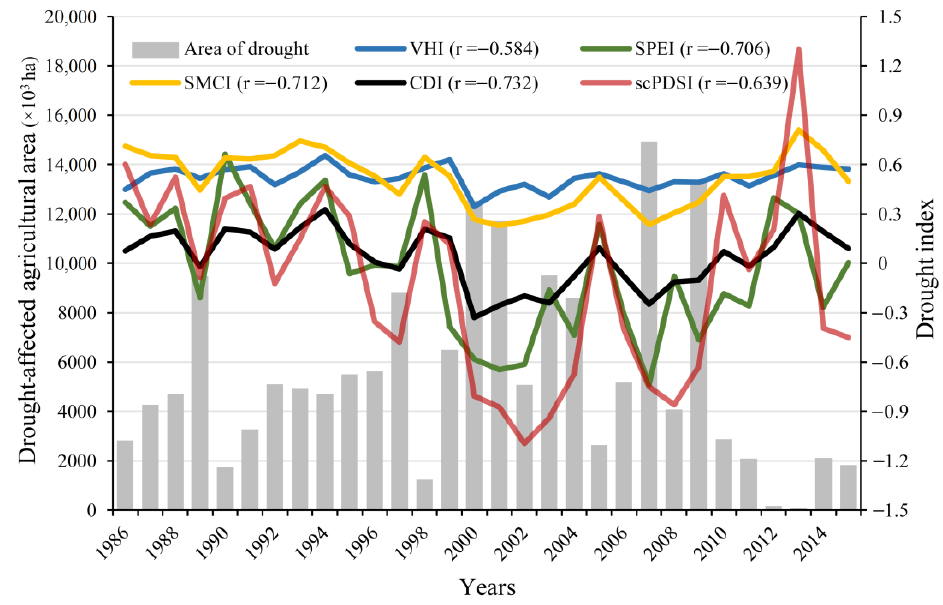
Figure 6. Temporal variation of drought-affected area of agriculture and different drought indices for farmland in NEC, 1986 –2015. (The scPDSI value typically ranges from −4 to 4, and here it is divided by 4.)